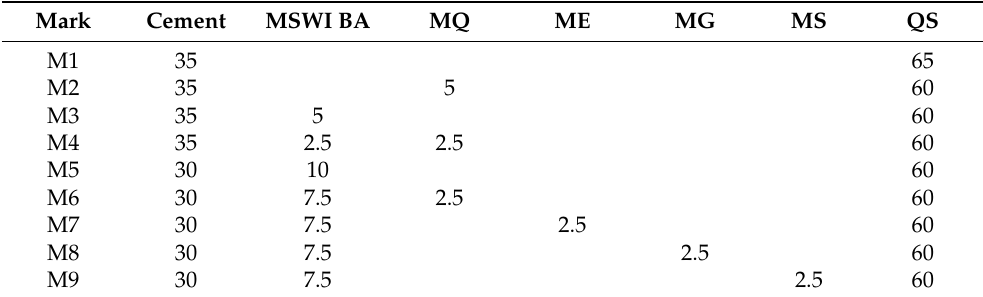
Table 2. Compositions of the cement mortar (%) by mass.